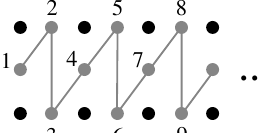
Figure 4: Labeling of the bond variables of the two-leg